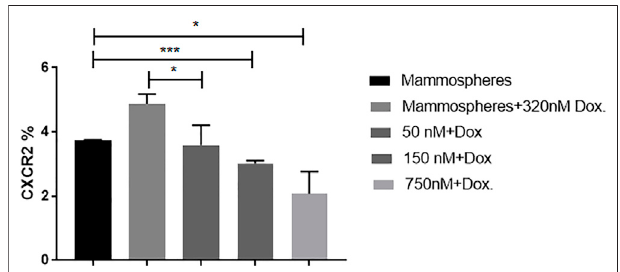
FIGURE 4 | AZD5069 inhibits doxorubicin-mediated CXCR2 overexpression and restores primary levels of the receptor. The cyto fl uorimetric analysis for CXCR2 expression in mammospheres in control and treated combinations; data are expressed as CXCR2 percentage; Dox: doxorubicin; AZD: AZD5069. p values, unpaired Student ’ s t-test.